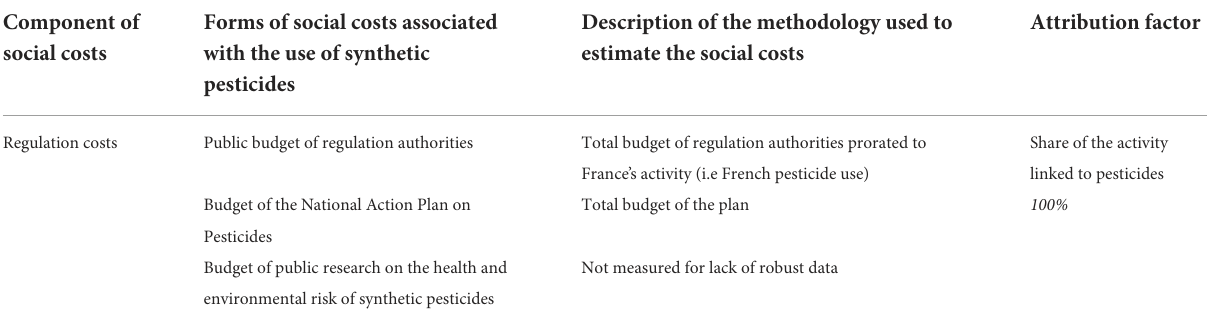
TABLE 1 Forms and description of the regulation costs associated with the use of synthetic pesticides in France. Component